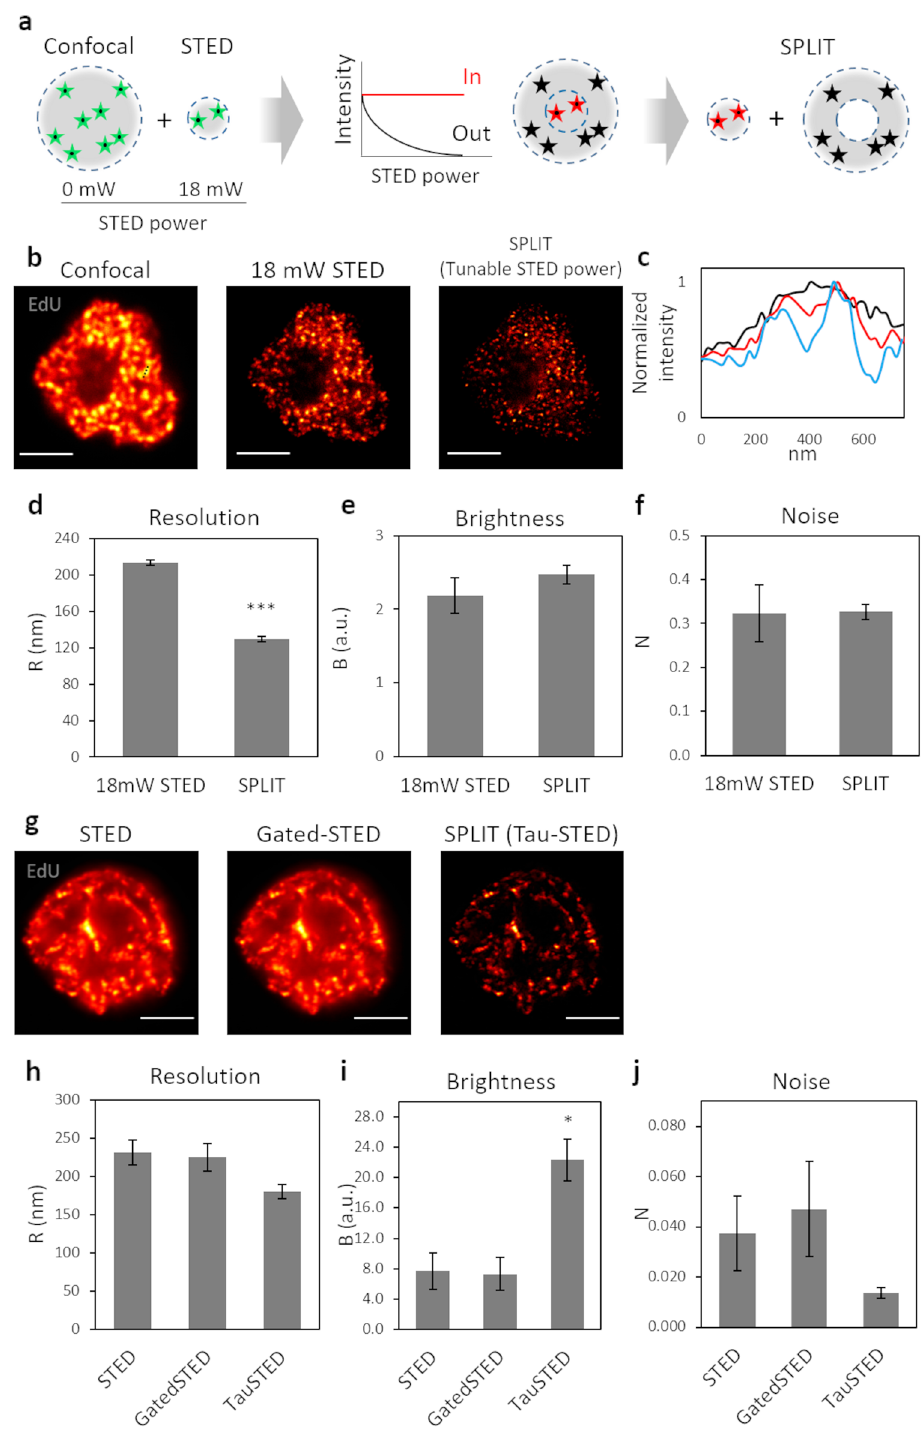
Figure 4. Comparison between SPLIT and STED imaging. ( a ) Schematic representation of the SPLIT principle using a tunable STED depletion power. The sequential acquisition with an increased STED depletion power from 0 to 18 mW, allow to obtain the extra information about the fluorescence depletion dynamics of photons arising from the center (in) and the periphery (out) of the PSF. ( b ) Representative images of U937-PR9 cells upon staining of DNA replication foci. Sequential acquisition of a confocal image (STED depletion power: 0 mW) and a STED image with a 18 mW depletion beam, followed by the resulting SPLIT image. Scale bars represent 3 µm. ( c ) Comparison between the line profiles of the same structure in the confocal (black line), the STED (red line) and the SPLIT (blue line) images of ( b ). The measured structure is defined by a black dotted line in the confocal image. ( d – f ) Quantification of Resolution, Brightness, and Noise parameters by application of the QuICS algorithm. At least ten 18 mW STED images have been acquired and compared to the resulting SPLIT images. Error bars represent the SEM and ***p < 0.001. ( g ) Images of U937-PR9 cells upon staining of DNA replication foci through incorporation of EdU labeled with Alexa azide 594. Images acquired with the Leica Stellaris 8 Tau-STED microscope. Shown are the raw STED image, the gated-STED image with a time-gating of 1–8 ns and the Tau STED image. Scale bars represent 3 µm. ( h – j ) Quantification of Resolution, Brightness, and Noise parameters of images shown in ( g ) by application of the QuICS algorithm. Error bars represent the SEM and *p <